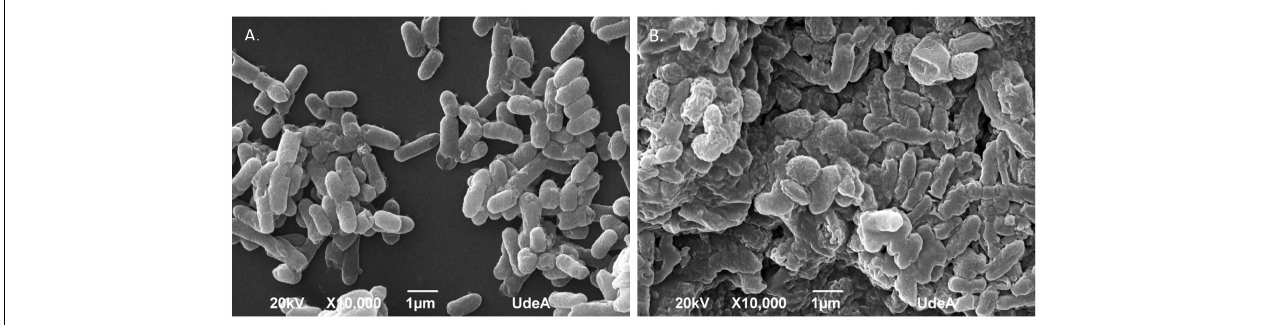
FIGURE 7 | Scanning electronic microscopy of Salmonella enterica subsp. enterica ATCC51741. (A) Untreated bacteria; (B) cells treated with PC from UTNGt21A at 1 × MIC for 6 h. Scale bars correspond to 500 nm and 1 µ m.